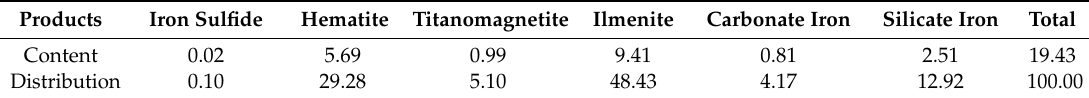
Table 3. Phase analysis of iron (%).